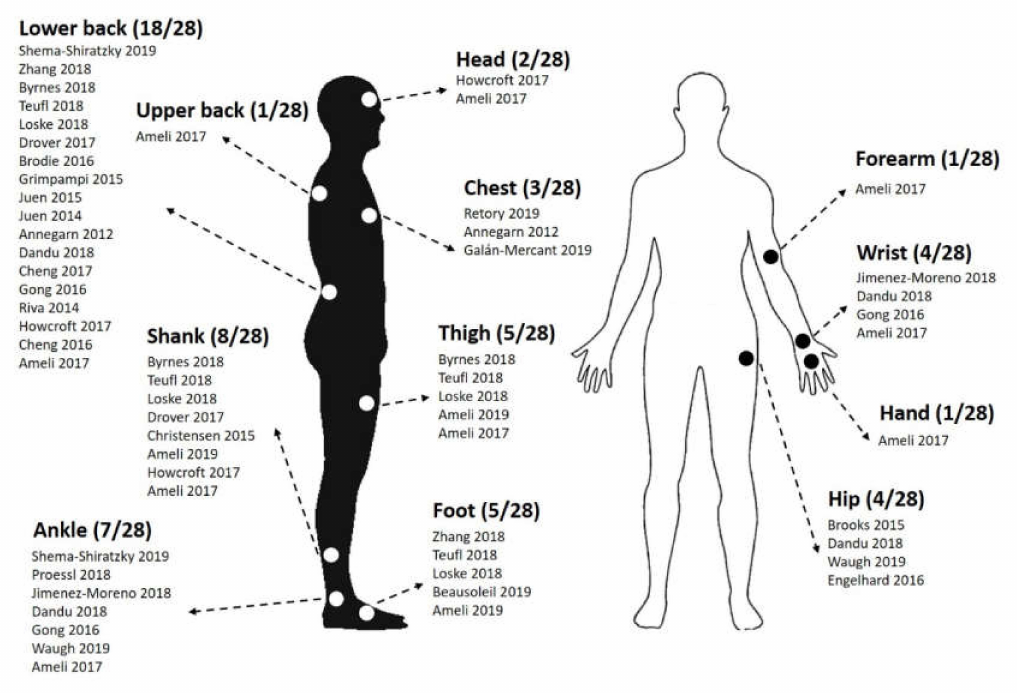
Figure 2. Sensor placement reported in the reviewed